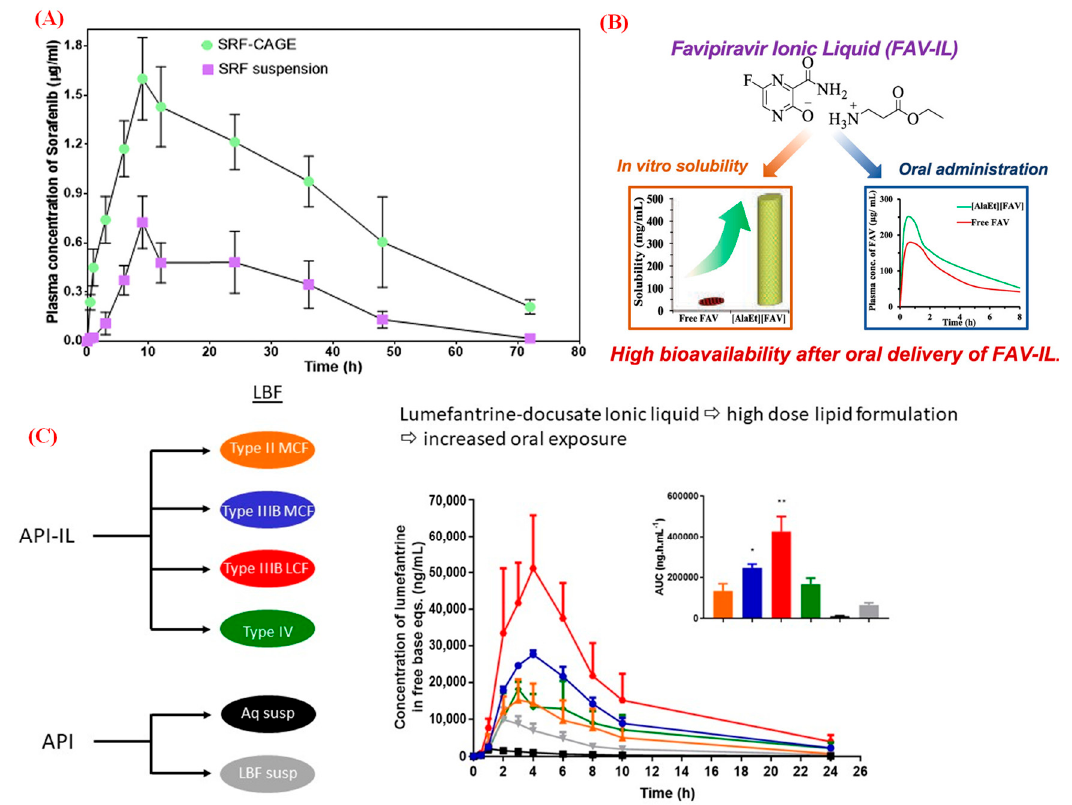
Figure 7. Schematic representation of the oral administration of ( A ) CAGE-containing sorafenib (SRF) drug [97]; and the IL forms of ( B ) favipiravir [89] and ( C ) lumefantrine [103]. Data are mean ± SD ( n = 4). * p < 0.05) when compared to both suspensions. ** p < 0.05) from all other formulations; reproduced with permission from refs.